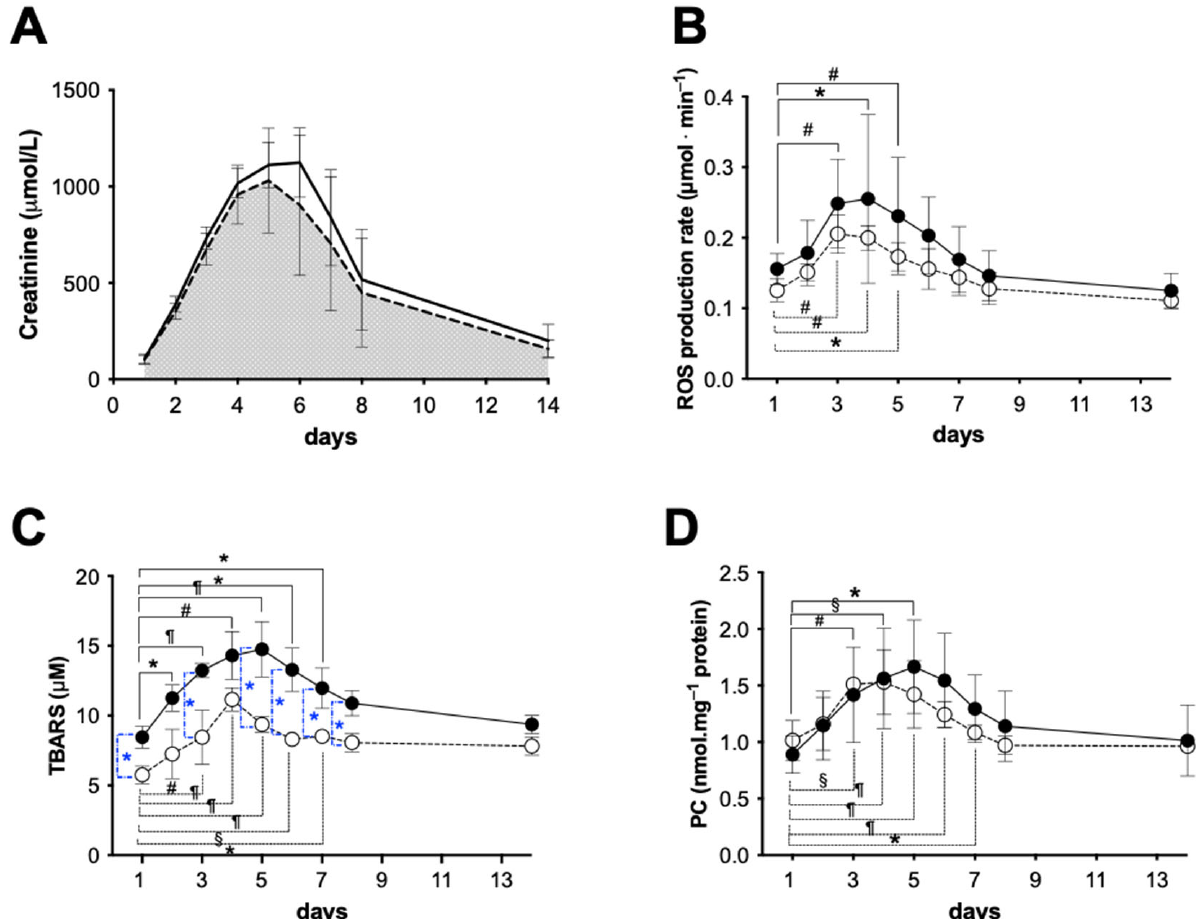
Figure 4. Renal functionality and oxidative stress after kidney re-implantation: ( A ) Serum creatinine concentration (mg/dL) measured from the HMP (dashed line) and SCS (continuous line) groups and areas under the curves (AUC); ( B ) Reactive oxygen species production rate (ROS, µ mol · min − 1 ) detected by EPR technique; ( C ) Thiobarbituric-acid-reactive substances (TBARS, µ M); and ( D ) Protein carbonyl (PC, nmol · mg − 1 protein) from 1st day to 14th day after kidney transplantation in static cold storage (SCS, full symbols) and hypothermic machine perfusion (HMP, empty symbols) groups. Continuous brackets indicate the significance of the intra-group data with respect to the first day. Blue stars ( C ) indicate the significance between HMP and SCS data at the same day. The data are expressed as mean ± SD. Significant differences: * p < 0.05; # p < 0.01, § p < 0.001, and ¶ p <